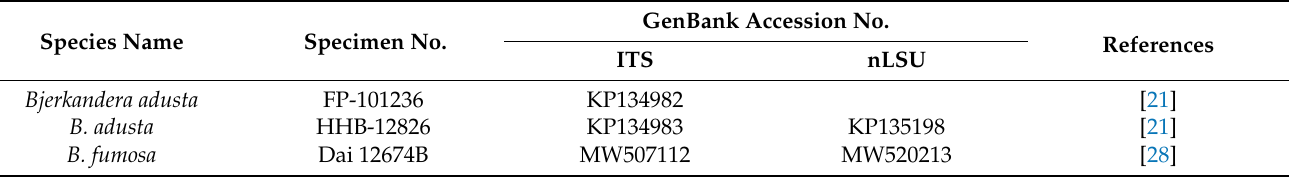
Table 1. List of species, specimens, and GenBank accession numbers of sequences used in this study. Species Name Specimen